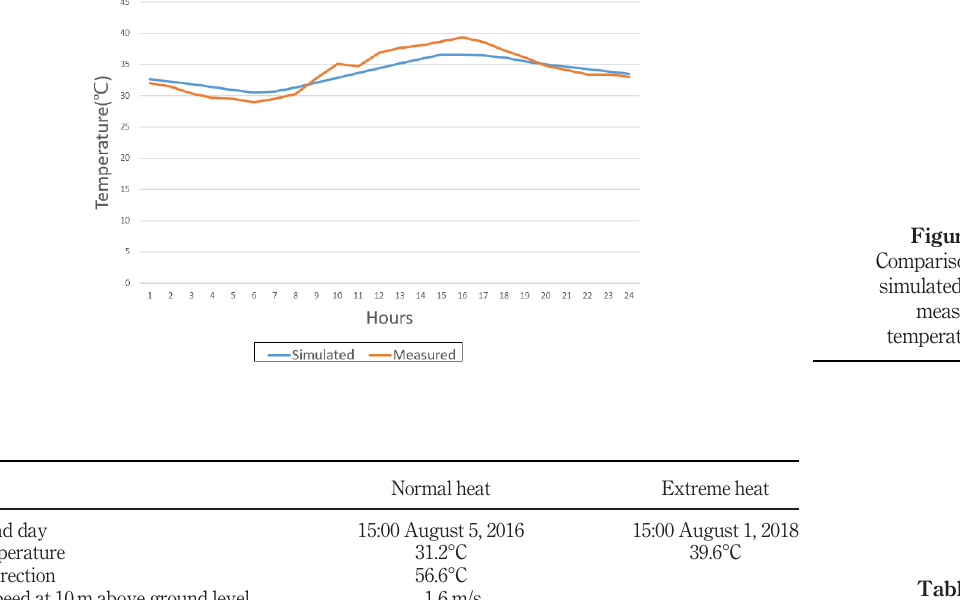
Table 1. Con fi guration